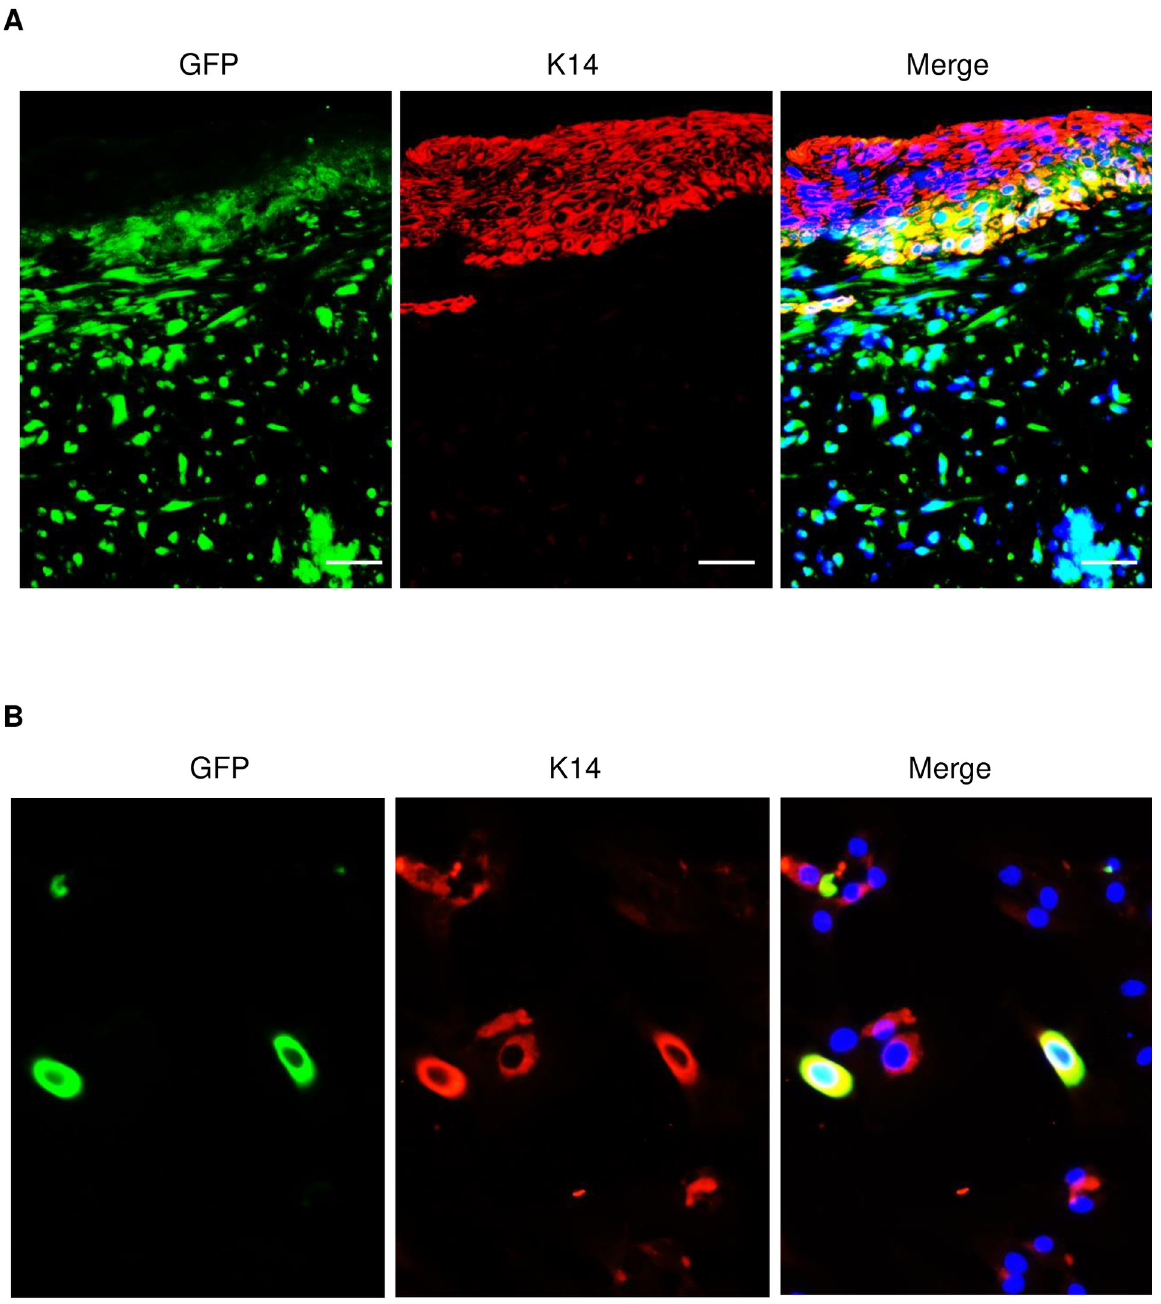
Fig 5. Conversion of GFP-expressing myeloid cells to keratinocytes in re-epithelialized wounded skin. ( A ) Double immunofluorescent staining with antibodies of GFP (green) and K14 (red) in healed skin from wounds of C57BL/6 mice received one million GFP-expressing splenocyte-derived myeloid cells. ( B ) Double immunofluorescent staining with K14 (red) and GFP (green) antibodies in cultured skin cells. Skin cells were isolated from wound edge of mice received GFP-expressing myeloid cells and injury for 14 days. Cells were cultured for 48 hours before fixation and staining. DAPI (blue) was used as a nuclear counterstain. Scale bars in all images was 50 μ m.